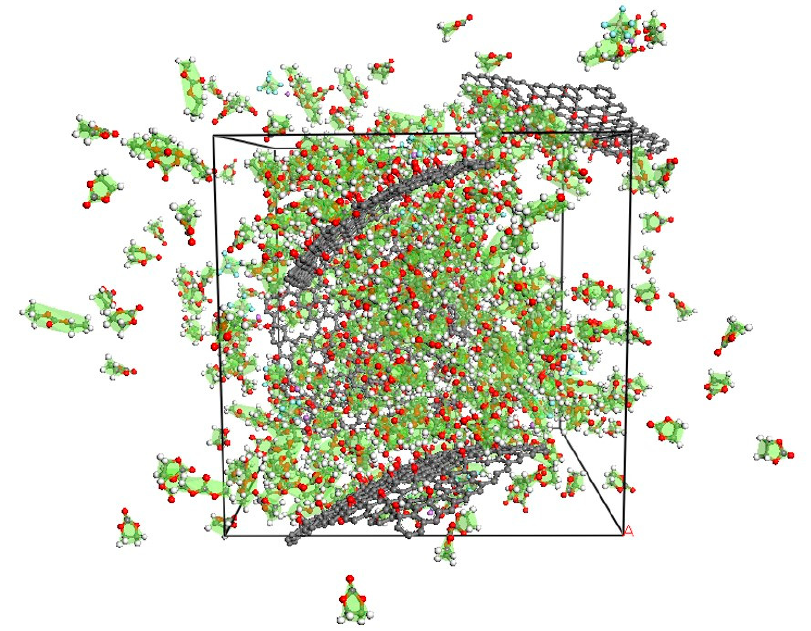
Figure 2. Snapshot of the initial simulation box for the HGNS/electrolyte system.